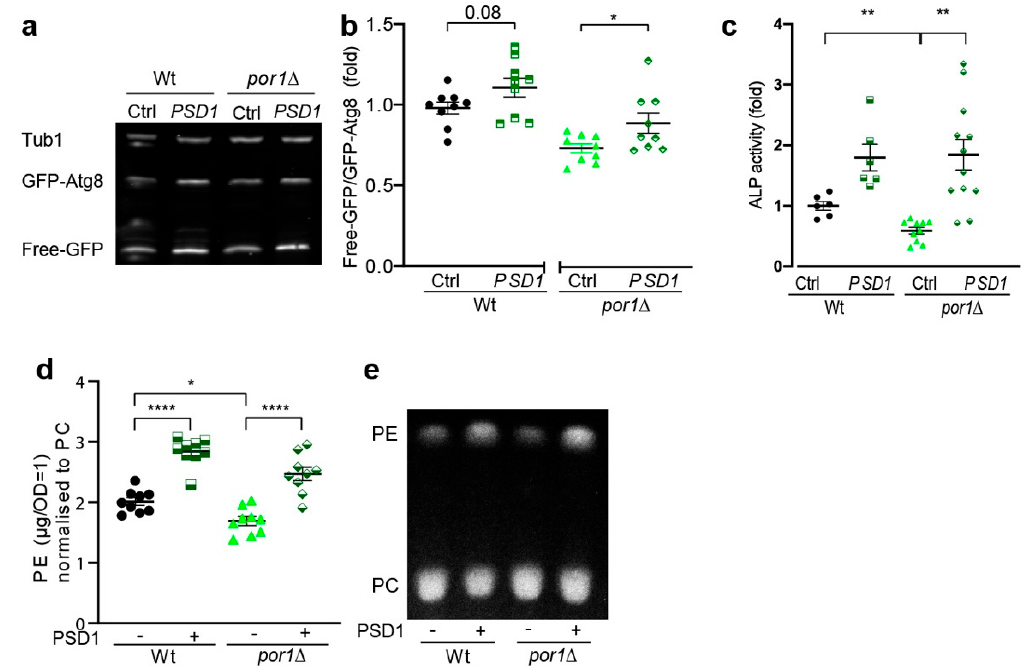
Figure 4. PSD1 overexpression could partially compensate for the loss of POR1 . ( a – c ) PSD1 overexpression increases autophagy in por1 ∆ . A representative immunoblot is depicted in ( a ) and free-GFP/GFP–Atg8 ratios of wildtype (Wt) and por1 Δ cells 24 h after induction of PSD1 overexpression are plotted in ( b ). Immunoblots were probed with GFP- and tubulin-specific antibodies and the signals were normalised to wildtype expressing an empty vector (Ctrl) ( n = 9). Alkaline phosphatase activity was assessed using the Pho8 ∆ 60 assay as a second readout to measure autophagic flux ( n ≥ 6) ( c ). ( d , e ) PSD1 overexpression increases PE-to-PC ratios in wildtype (Wt) and por1 ∆ . Quantification of PE-to-PC ratios based on TLC is shown in ( d ) ( n = 9) and a representative TLC section is shown in ( e ) . Statistical analysis was performed with GraphPad Prism. Statistical analysis in ( b ) was performed by unpaired t -test, in ( c ) by Welch’s ANOVA, and ( d ) by one-way ANOVA. Error bars indicate standard error of the mean (SEM) and asterisks in the figures indicate significant differences, * p < 0.05, ** p < 0.01, **** p < 0.0001.